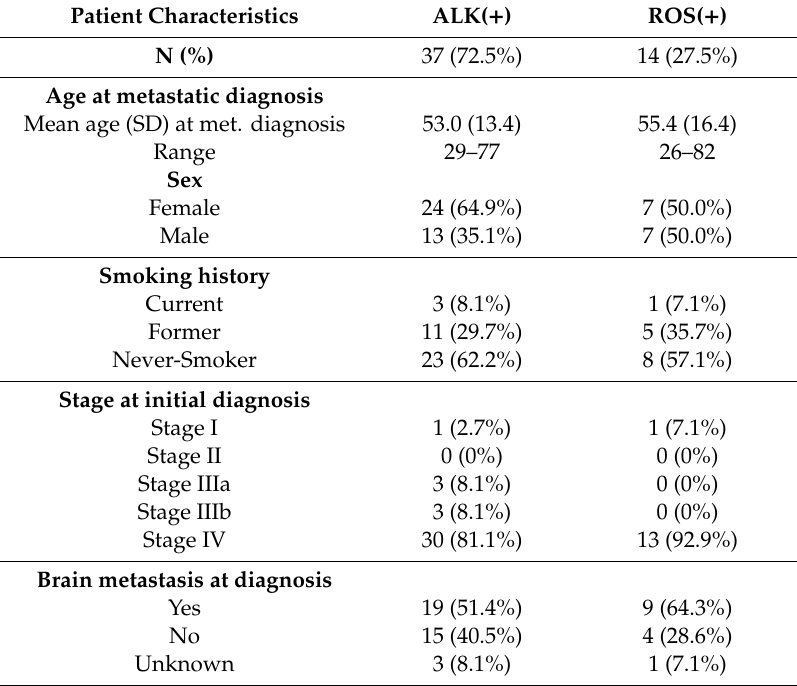
Table 1. Baseline Patient